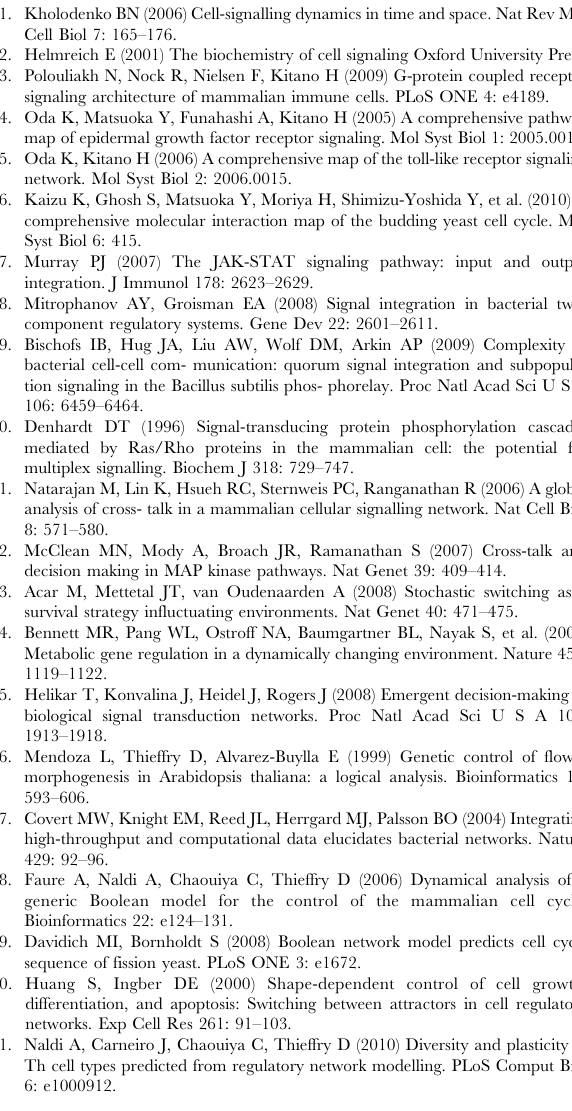
Figure S11 Robustness to asynchronous updating. Net- work response to periodic stimulation of input node stress spectral density of the output nodes (see legend in Figure 9), for